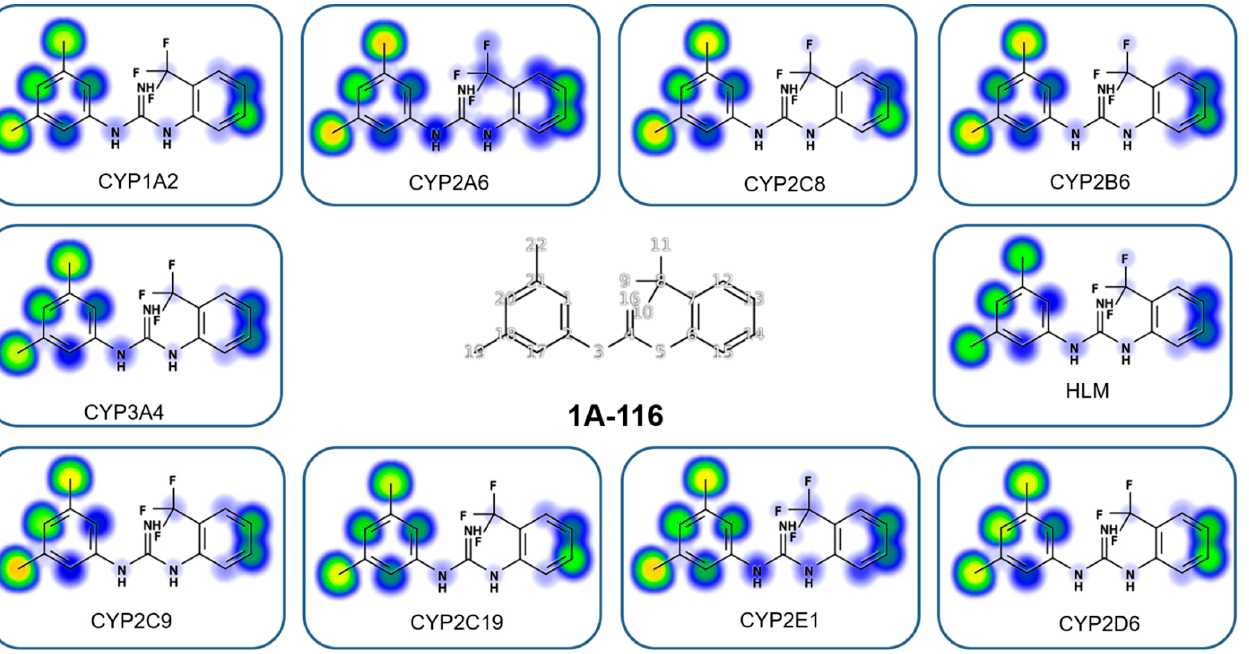
Figure 3. Predicted potential sites of metabolism (SOM) for 1A-116 using XenoSite predictor. Scores from 1 (red) to score zero (white) are shown on the 1A-116 chemical structure. Potential sites for nine CYP450 isoenzymes and HLM are shown.